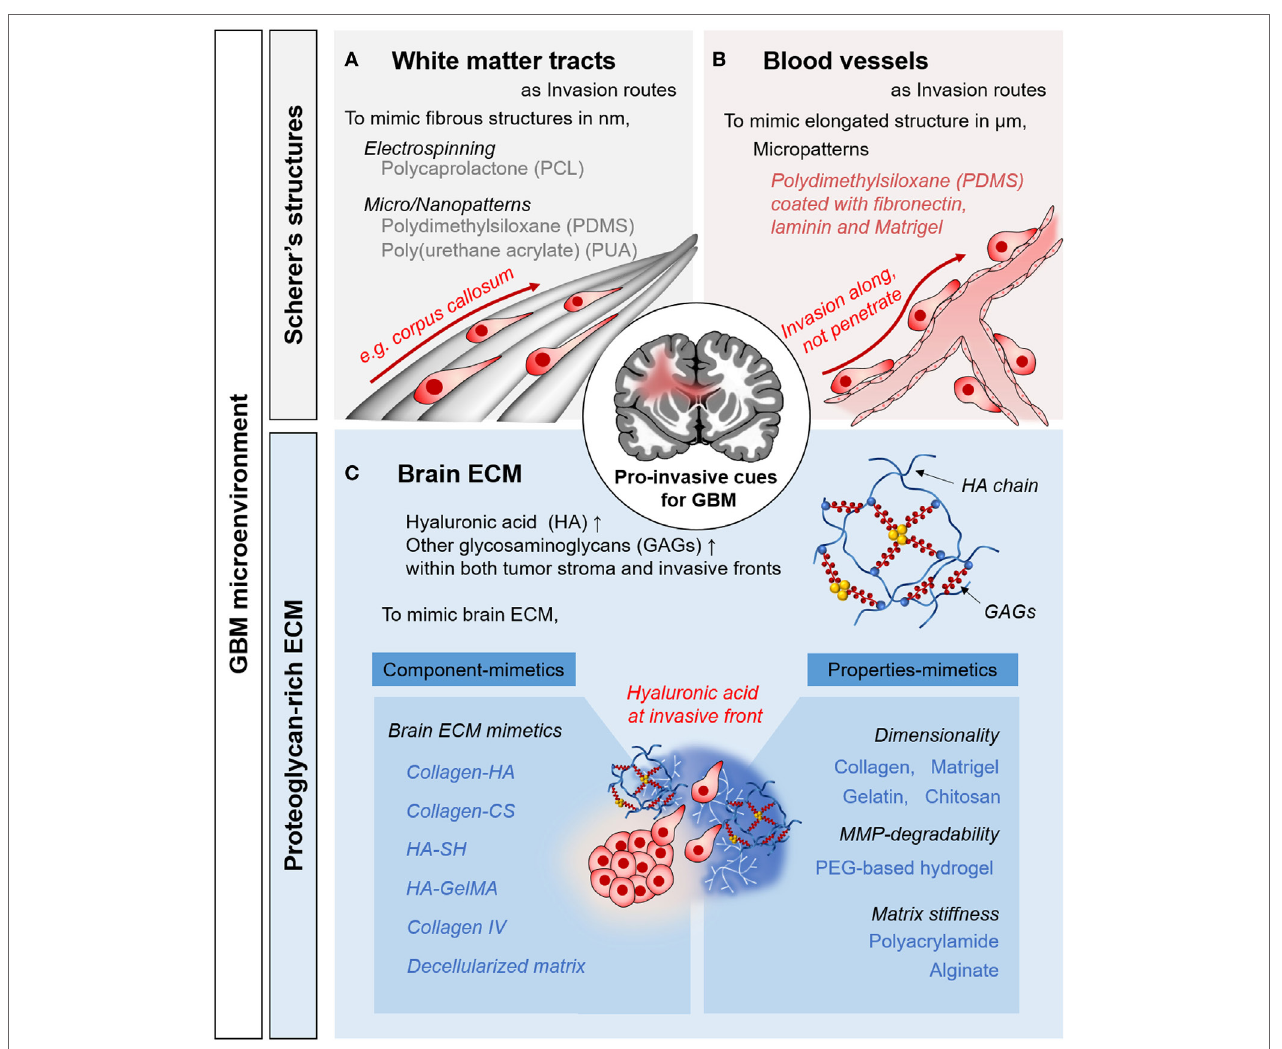
FiGURe 1 | Pro-invasive cues in glioblastoma multiforme (GBM) microenvironments and in vitro approaches to mimic the microenvironmental cues. Representative examples of Scherer’s structures: white matter tract (A) and blood vessels (B) . (C) Proteoglycan-rich extracellular matrix (ECM) in tumorous brain